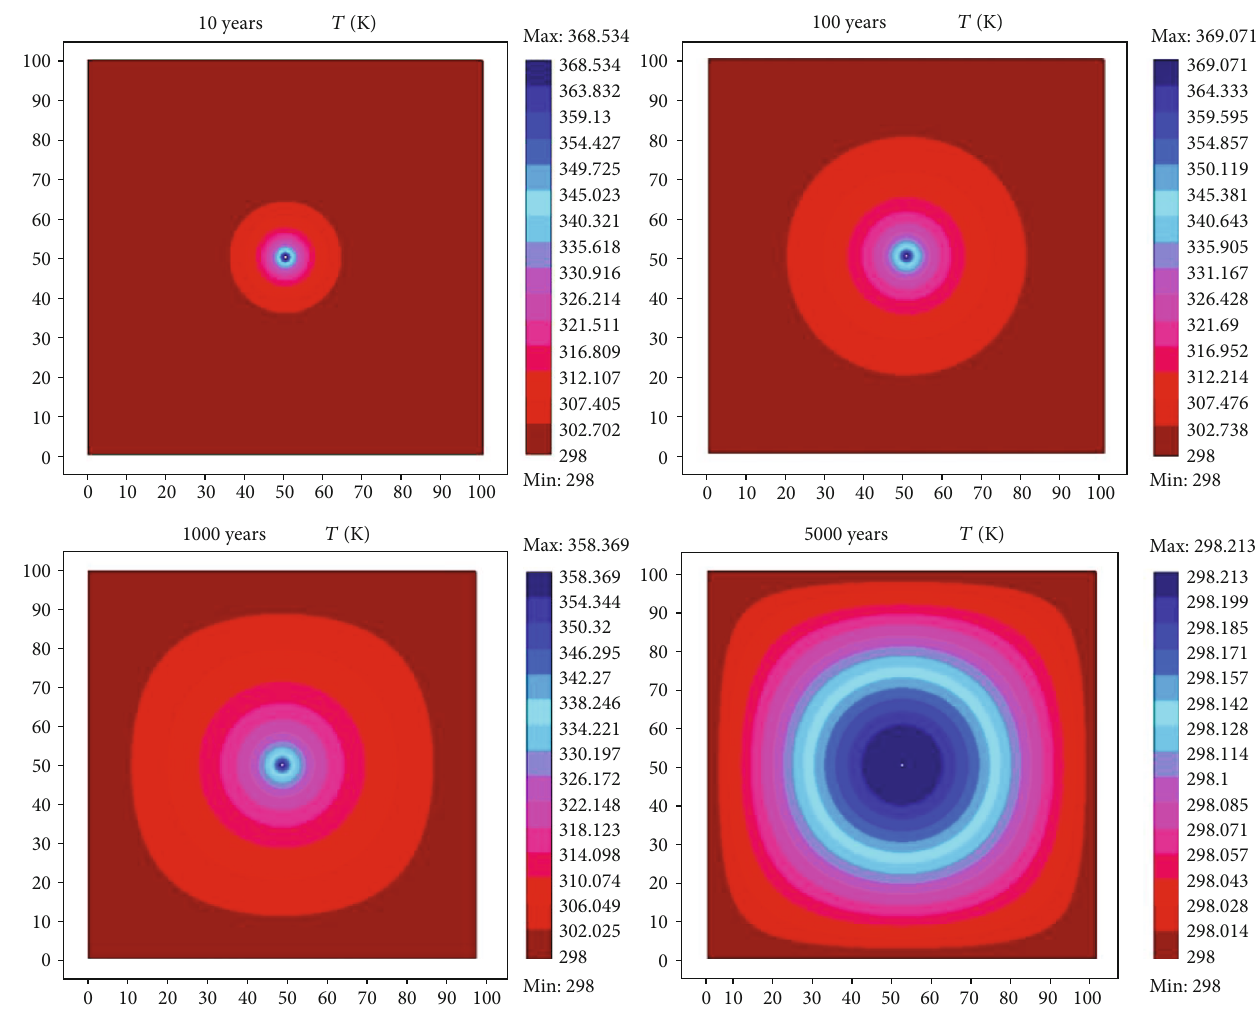
Figure 3: Spatial distribution of the reservoir temperature after 10, 100, 1000, and 5000